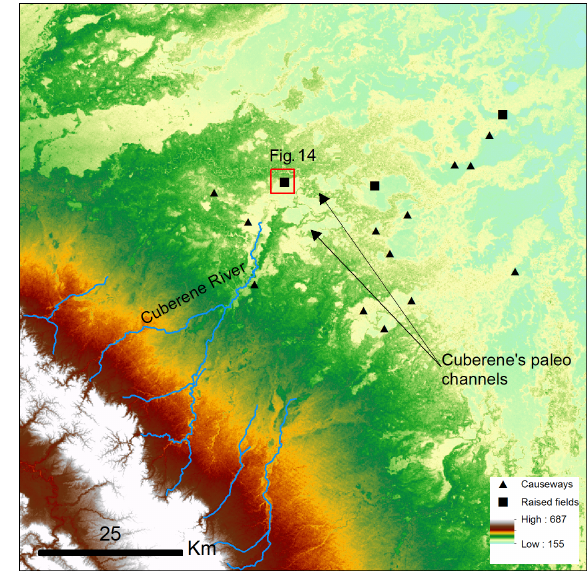
Figure 13. Location of pre-Columbian earthworks in the Chimane Forest and the location in Fig. 14. The triangles indicate the loca- tion of pre-Columbian causeways and the squares show the location of raised fields, which are pre-Columbian structures built to allow agriculture in otherwise flooded areas.